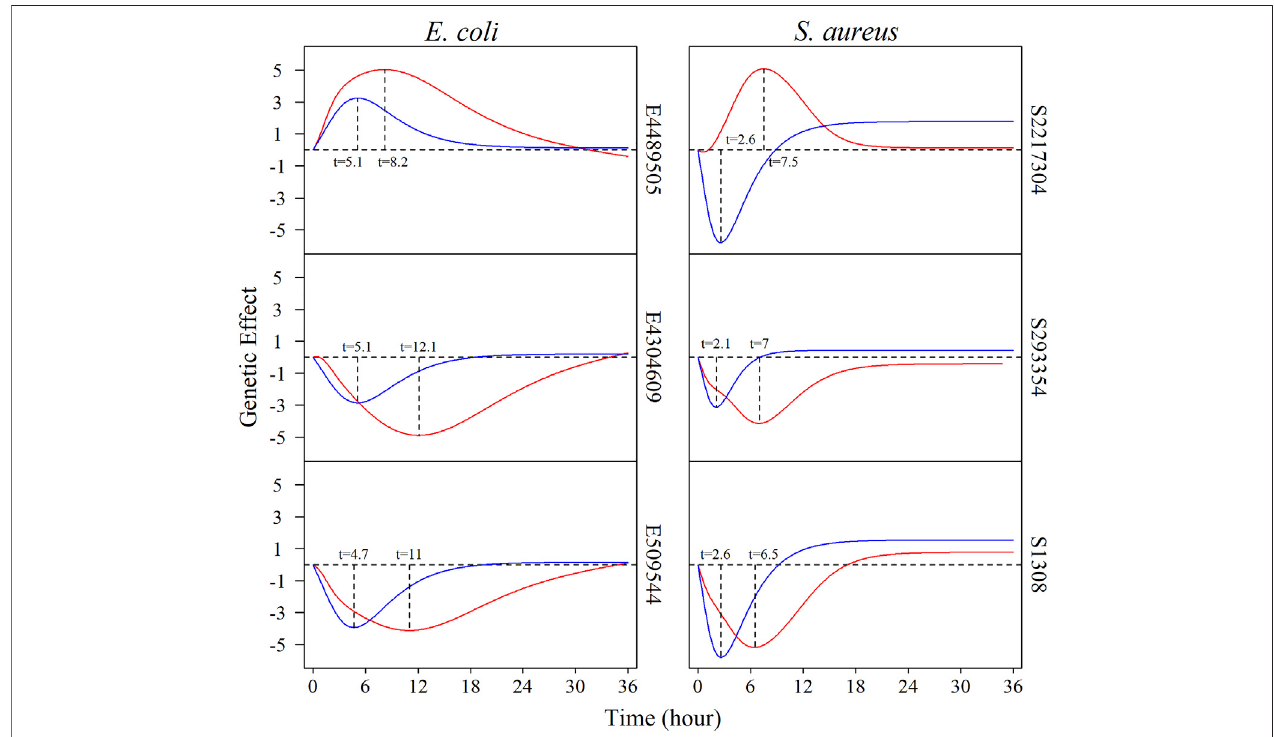
FIGURE 3 | The genetic effect curves regulated by common QTLs which are signi fi cant under both single culture and co-culture conditions. The left: the effect curvesof E.coli ofE4489505,E4304609,andE509544,respectively.The right: theeffectcurvesof S.aureus ofS2217304,S293354,andS1308,respectively.Thered lines represent the genetic effect under co-culture, and the blue lines represent the genetic effect under monoculture.